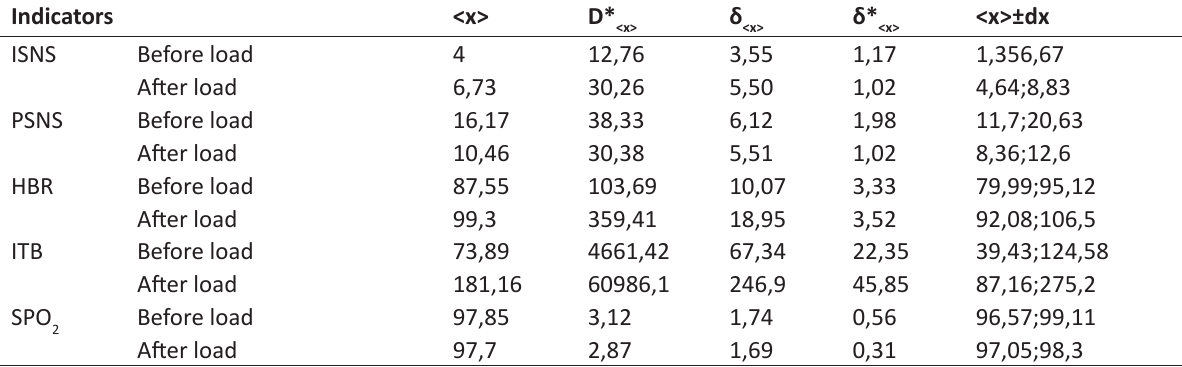
Table 3. Cardio-respiratory indicators of 2 nd group girls’ functional system after physical load Indicators